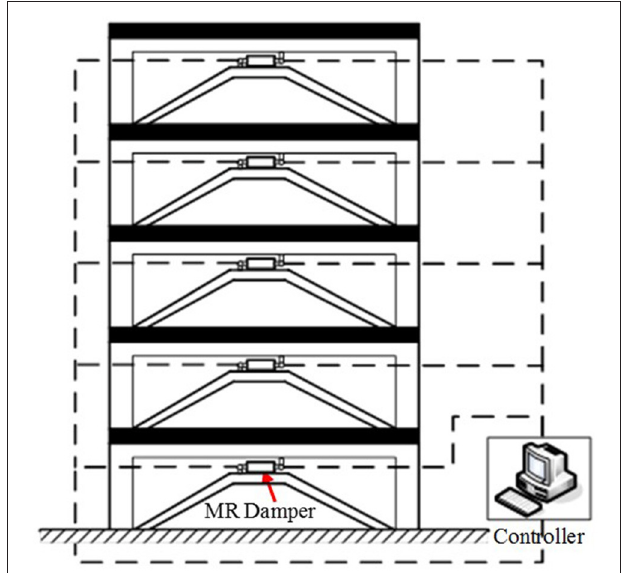
FIGURE 3 | The structure with MR